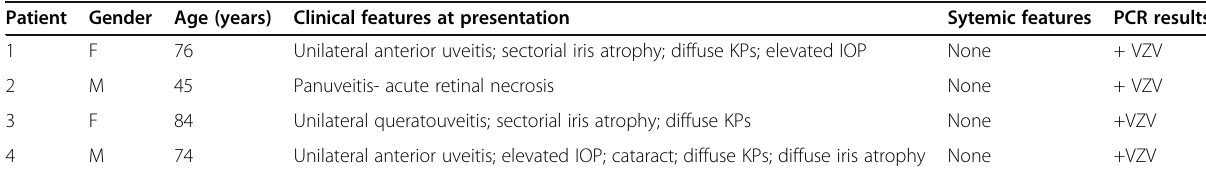
Table 1 Demographic and clinical features for the HU group Patient Gender Age (years) Clinical features at presentation Sytemic features PCR